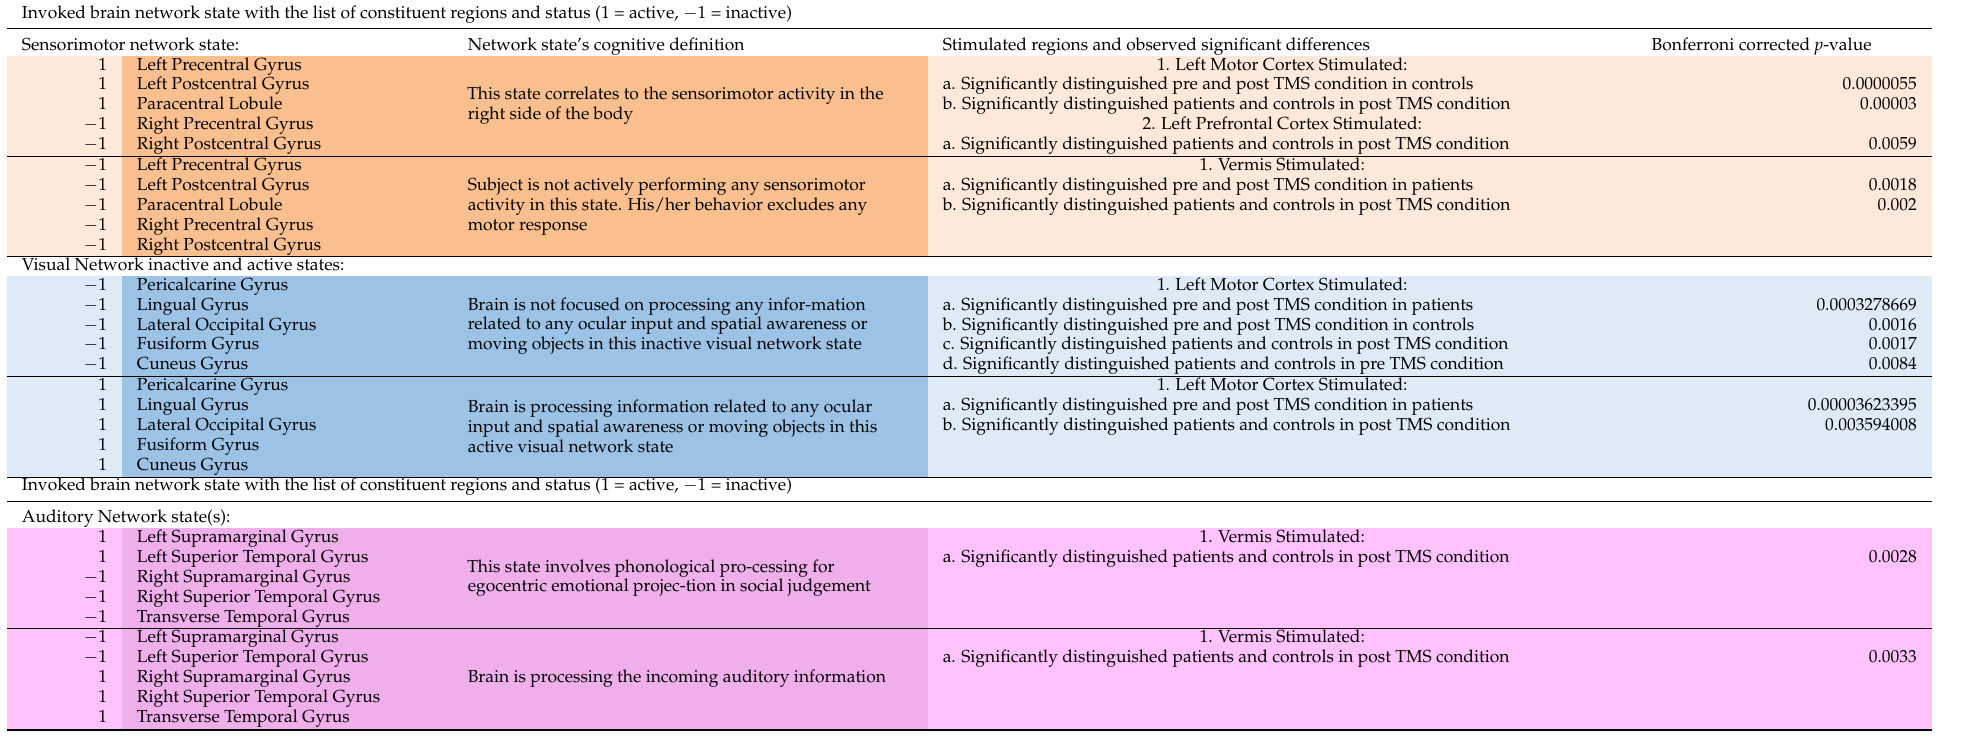
Table 3. Connectivity network state summary for the states of sensorimotor, visual, and auditory network when the left motor, left prefrontal cortex, and vermis are stimulated by the TMS subthreshold